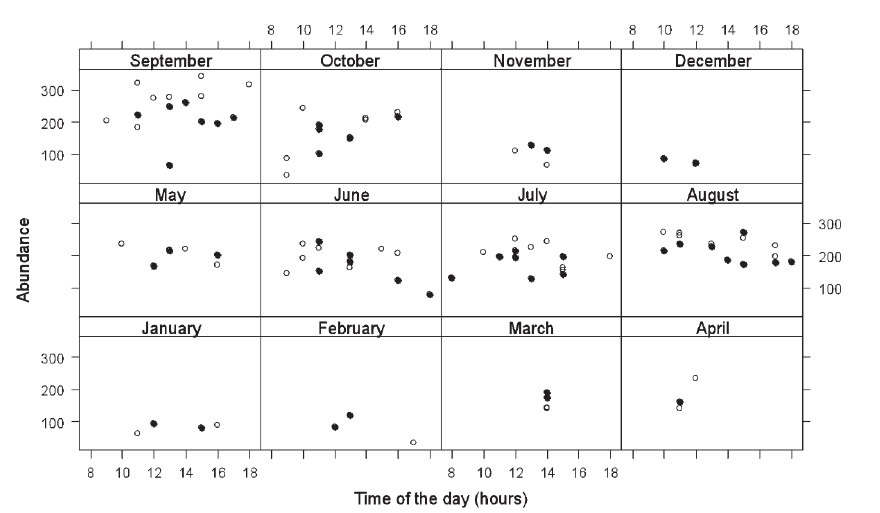
Fig. 3. Abundances versus time of the day for each month. Open circles are for site 1 (Bantry Bay) and filled circles for site 2 (Kenmare